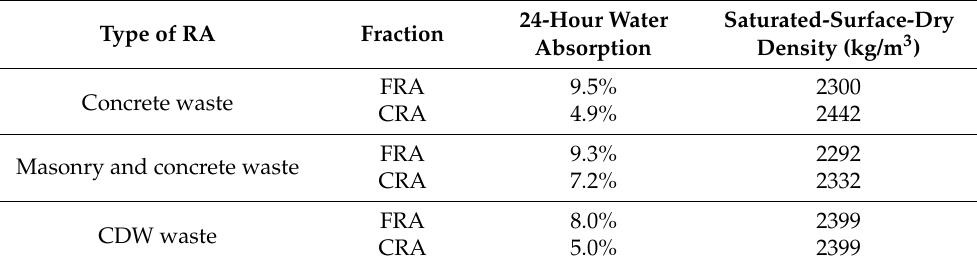
Table 3. Mean of the 24 h water absorption and saturated surface-dry density of RA [13]. Type of